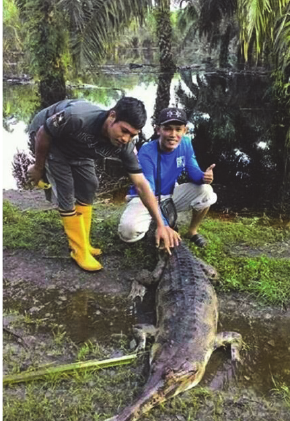
Figure2:Tomistomacaughton9/2/15inSamarahanRivertributary (total length = 2.4 m).